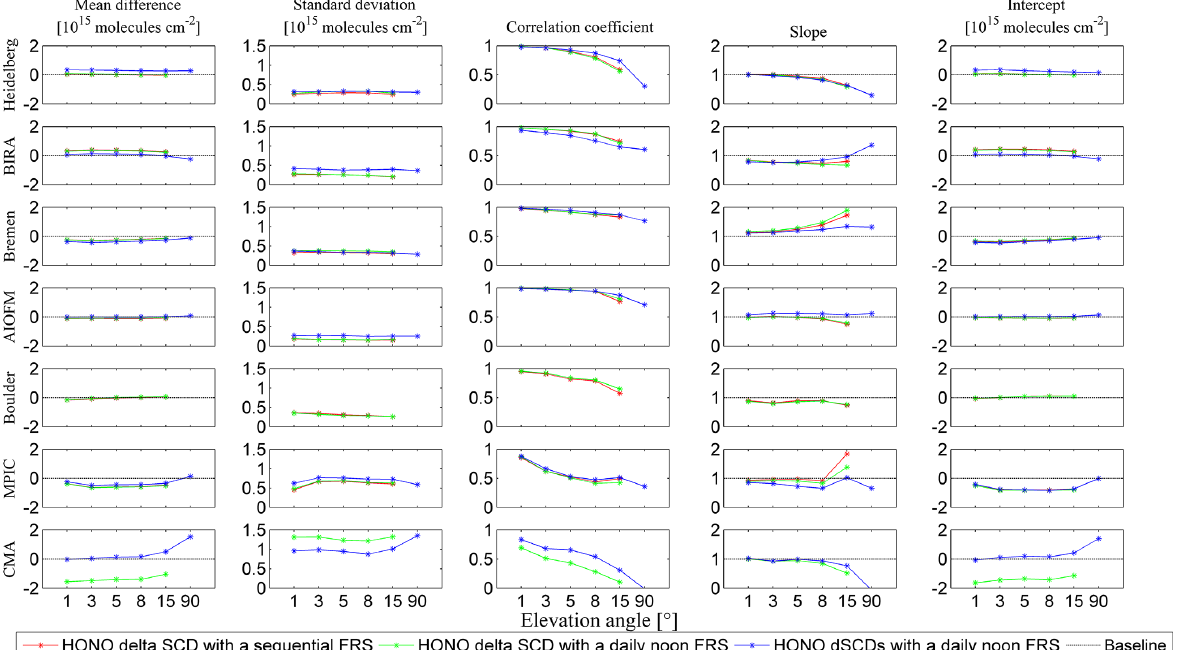
Figure 5. Mean differences and standard deviations as well as correlation coefficients, slopes and intercepts of linear regressions derived from comparisons of the HONO delta SCDs and dSCDs retrieved from different instruments with reference values as function of the elevation angle. The HONO delta SCDs are derived from fits with a sequential FRS (red curves) and a daily noon FRS (green curves). The HONO dSCDs are derived from fits with a daily noon FRS (blue